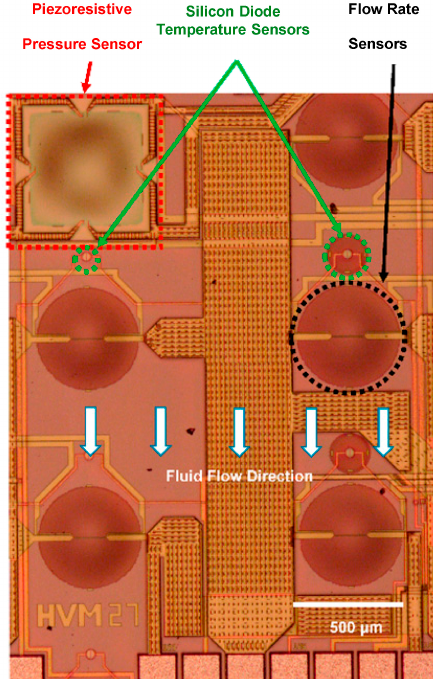
Figure 1. Partial view of the SOI CMOS multi-sensor MEMS chip capable of measuring fluid pressure, temperature and flow